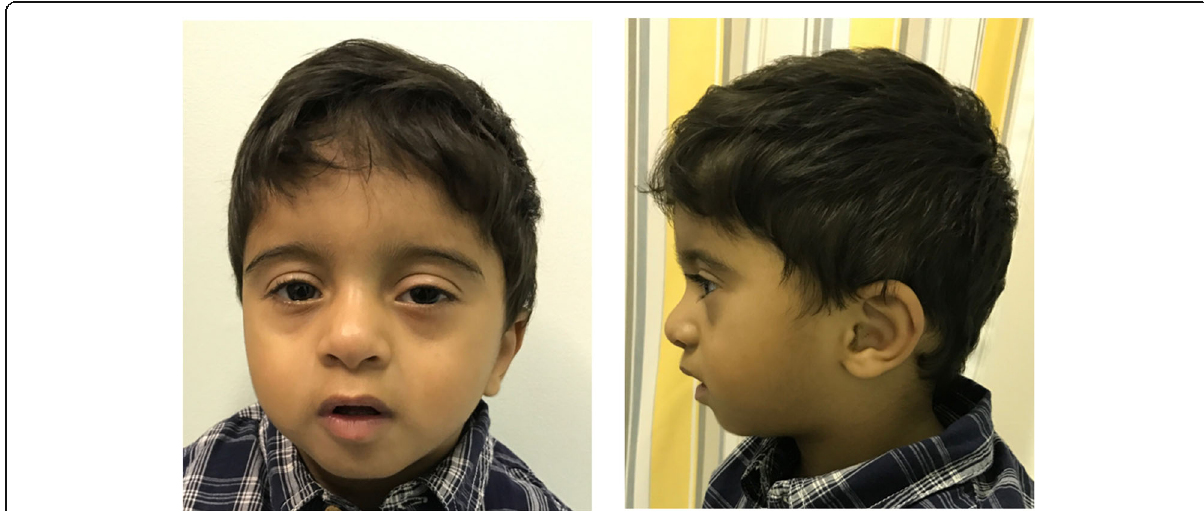
Fig. 1 Photograph showing the following distinctive facial features: straight eyebrows, bilateral ptosis with the left side being more pronounced than the right, up-slanted palpebral fissures, broad nasal bridge, low-set and posteriorly rotated ears, small mouth, thick lower lip, and